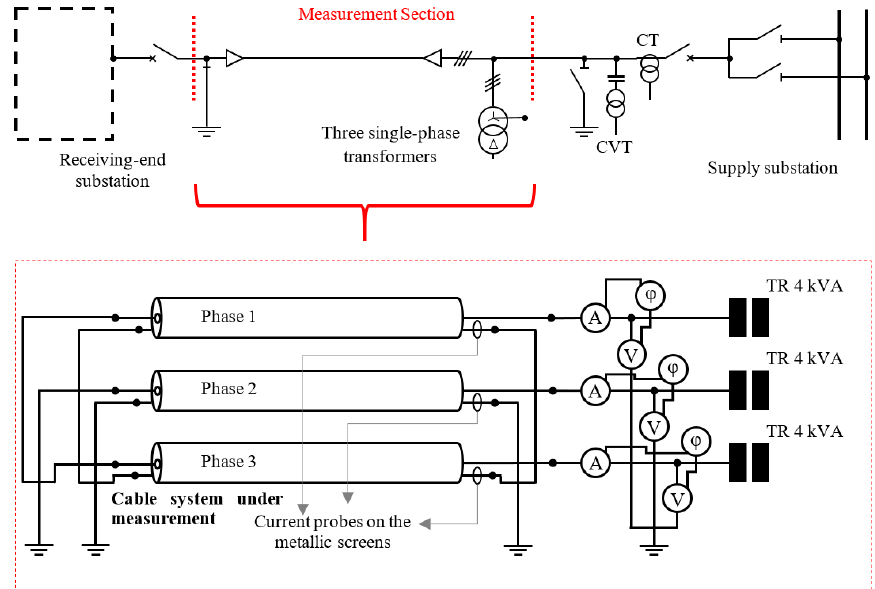
Figure 3. Equipment for measuring the positive sequence impedance. CT (not used for the sequence impedance measurements) and A stand for current transformer; CVT (not used for the sequence impedance measurements) and V stand for capacitor voltage transformer; ϕ stands for phasemeter.